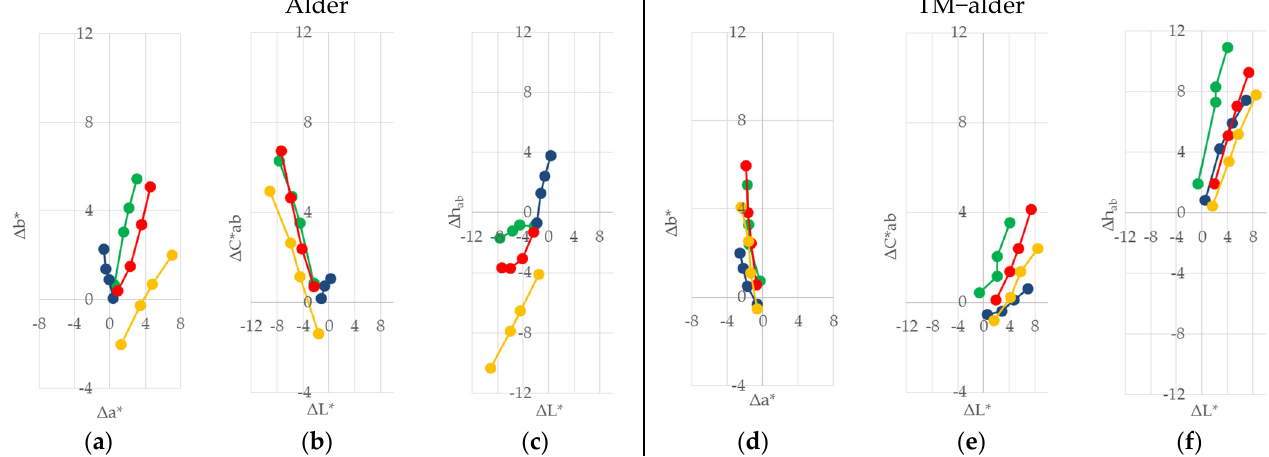
Figure 2. Changes in ∆ L* , ∆ a* , ∆ b* , ∆ C* ab , and ∆ h ab after the exposure to indoor sunlight of coated and uncoated native ( a – c ), and thermally treated ( d – f ), alder wood for 60 days. Note for Figures 2–5: green = uncoated wood; blue = coated with Acryl-PU; red = coated with PAcryl-Ald; and yellow = coated with Alk.